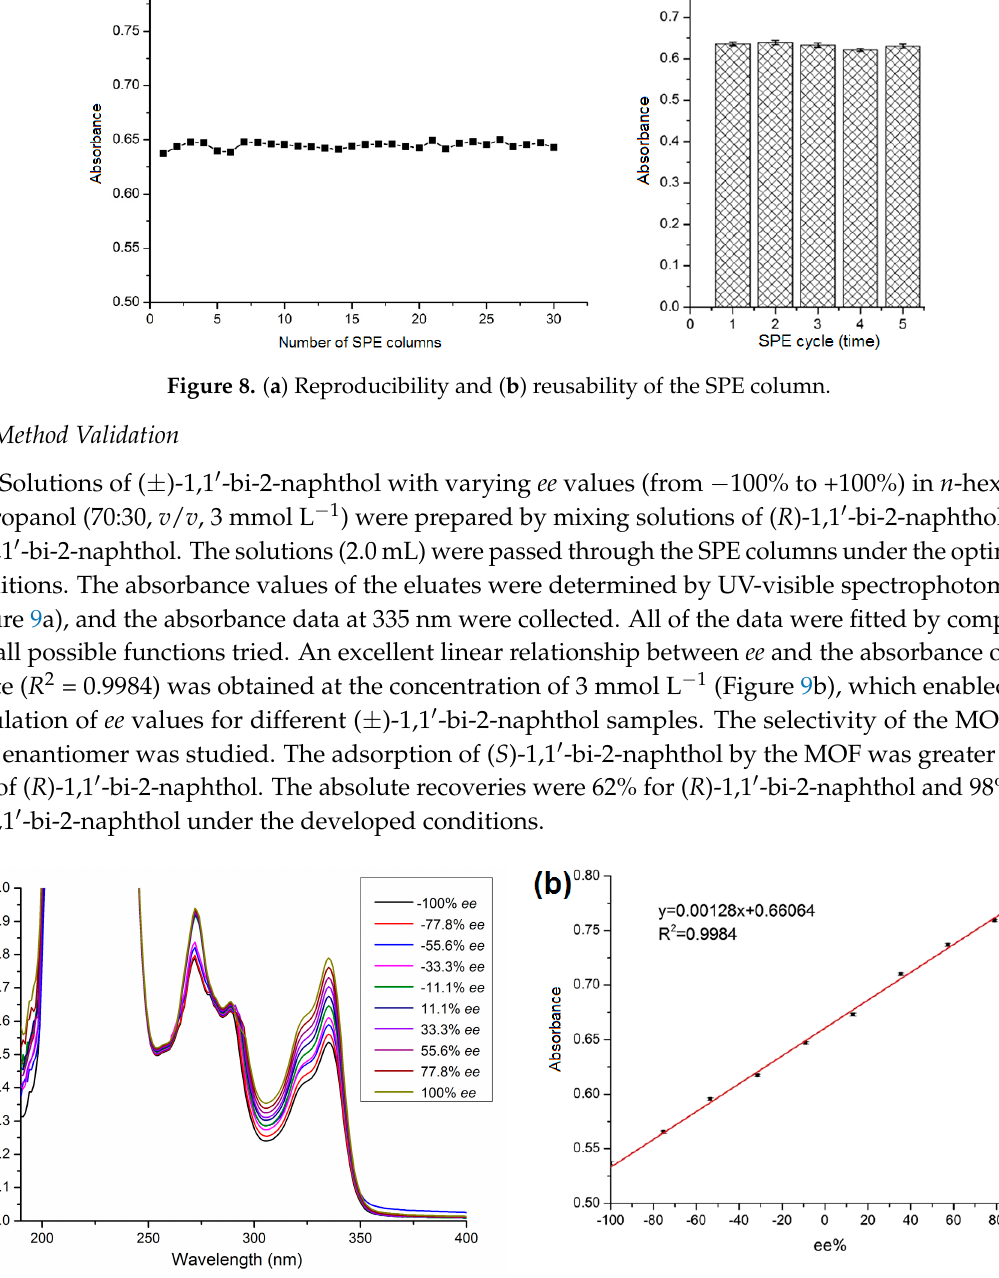
Figure 8. ( a ) Reproducibility and ( b ) reusability of the SPE column.